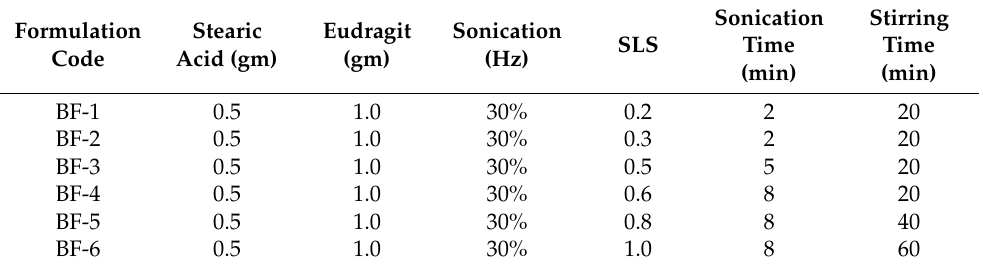
Table 1. Blank LPHNs formulations.